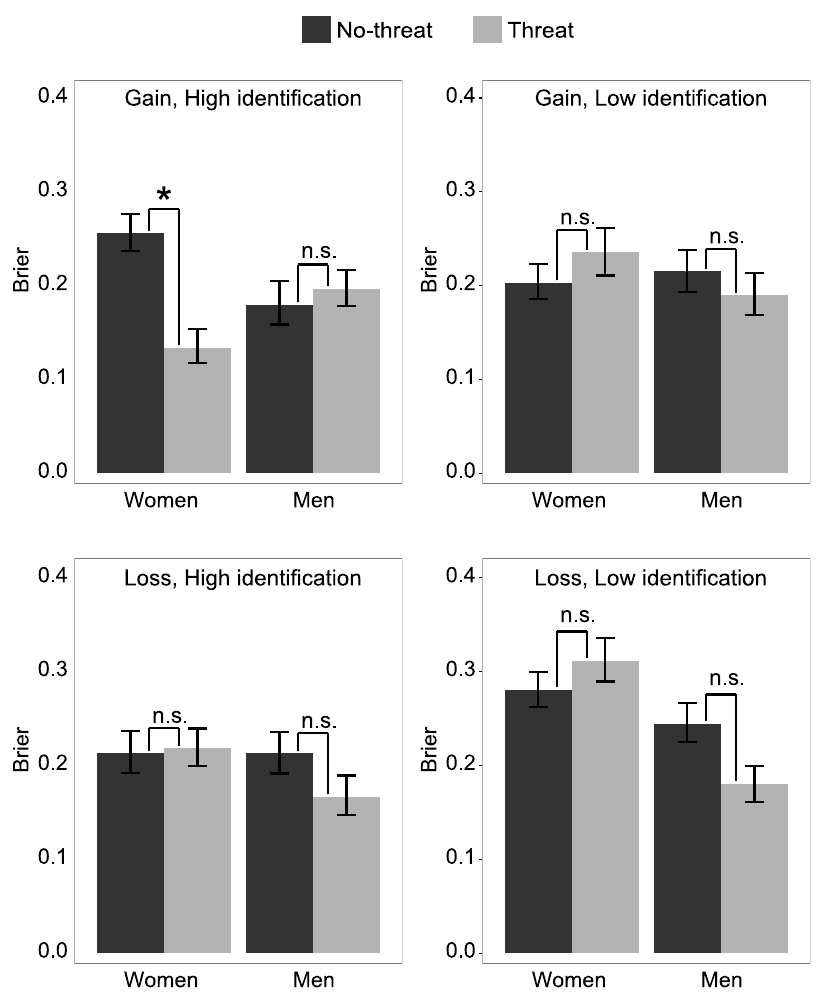
Fig 2. Brier scores. Mean Brier scores across participants, as a function of treatment (threat vs. no-threat), sex, frame (gain vs. loss) and identification (high vs. low). Error bars reflect 95% CI intervals. � : p < .05 (corrected for 2 comparisons); ns: p >